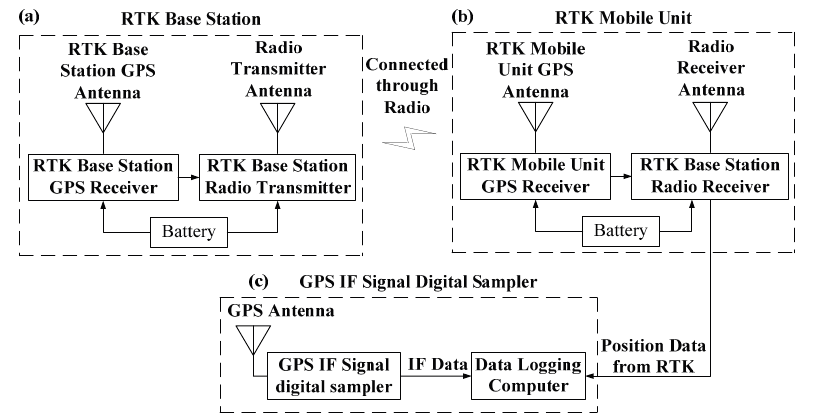
Figure 6. Test platform. ( a ) RTK base station; ( b ) RTK mobile unit; ( c ) GPS IF signal digital